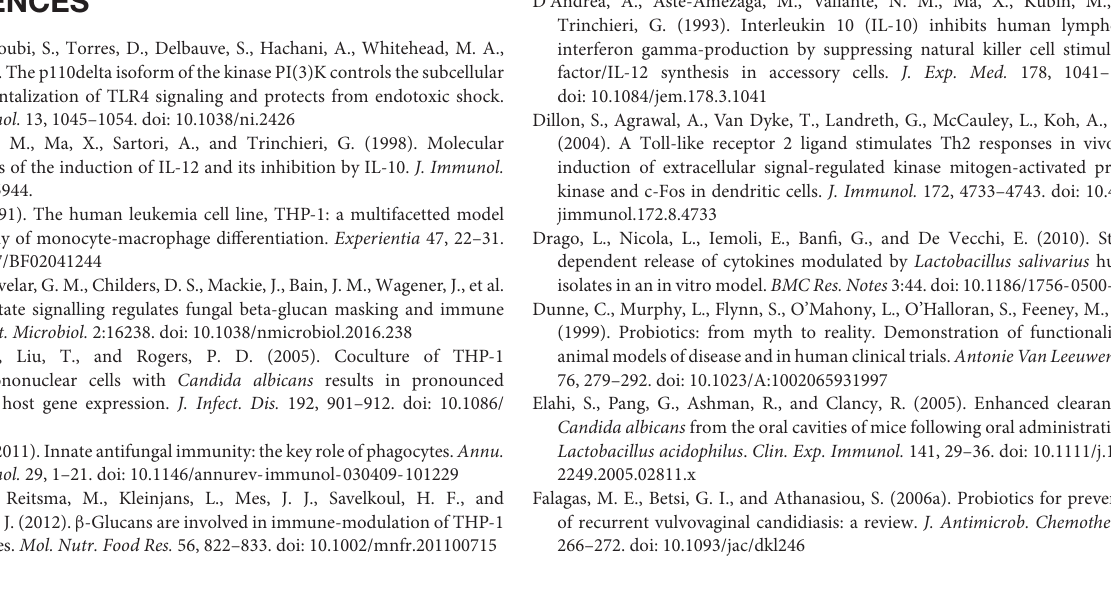
FIGURE S1 | Number of viable macrophage cells after the final incubation in the different groups. Data are presented as cells/well. FIGURE S2 | (A) Macrophages under different stimulation (cell with no challenge or LPS pretreated cells challenged with C. albicans ) incubated with isotype control antibody. (B) Flow cytometry gating on macrophages. FIGURE S3 | Flow cytometry data from control wells containing C. albicans or Lactobacillus strains submitted to anti-Human CLEC7A – Dectin-1 antibody. (A) macrophages alone with no antibody; (B) C. albicans + antibody; (C) L. rhamnosus + antibody; (D) L. acidophilus + antibody; (E) L. casei + antibody. Percentage of cells expressing the antibody, shown in each situation, reveals no non-specific binding in any control